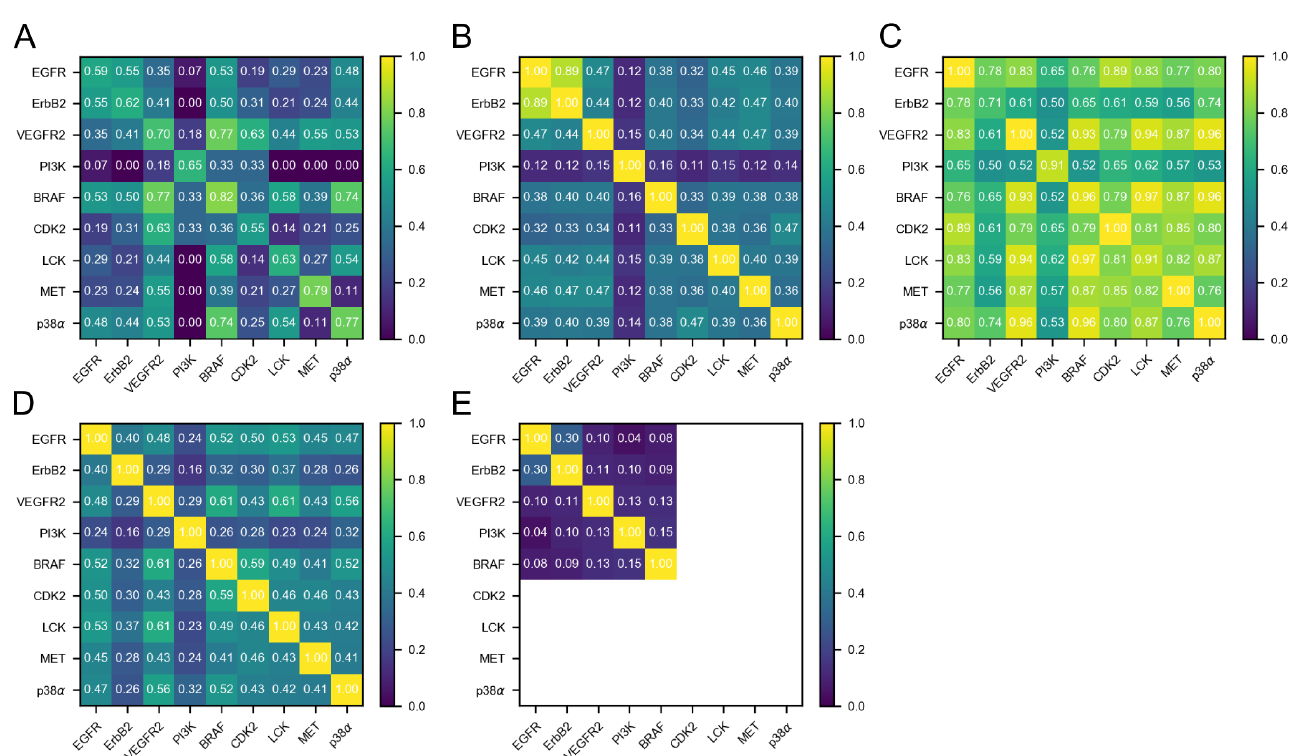
Figure 2. Heat maps of pairwise kinase similarities for the different measures used in this work: ( A ) ligand profile similarity (LigProfSim); ( B ) pocket sequence similarity (PocSeqSim); ( C ) interaction fingerprint similarity (IFPSim); ( D ) pocket structure similarity (PocStrucSim); and ( E ) docking rank similarity (DockRankSim) based on the lead-like subset of ZINC. Note that docking was only performed for the five kinases of Profiles 1–4, thus the remaining entries remain empty (white) in the